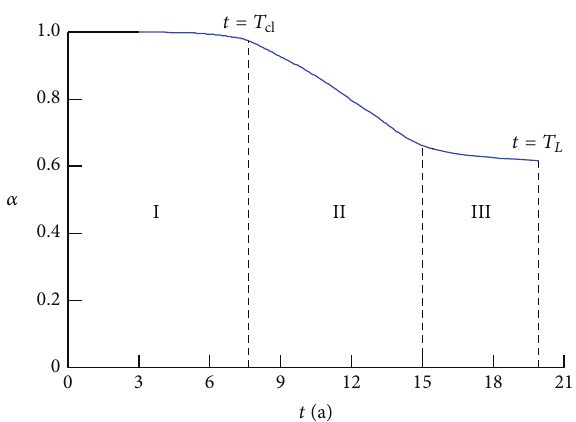
Figure 8: Effect of corrosion on reduction in pile foundation